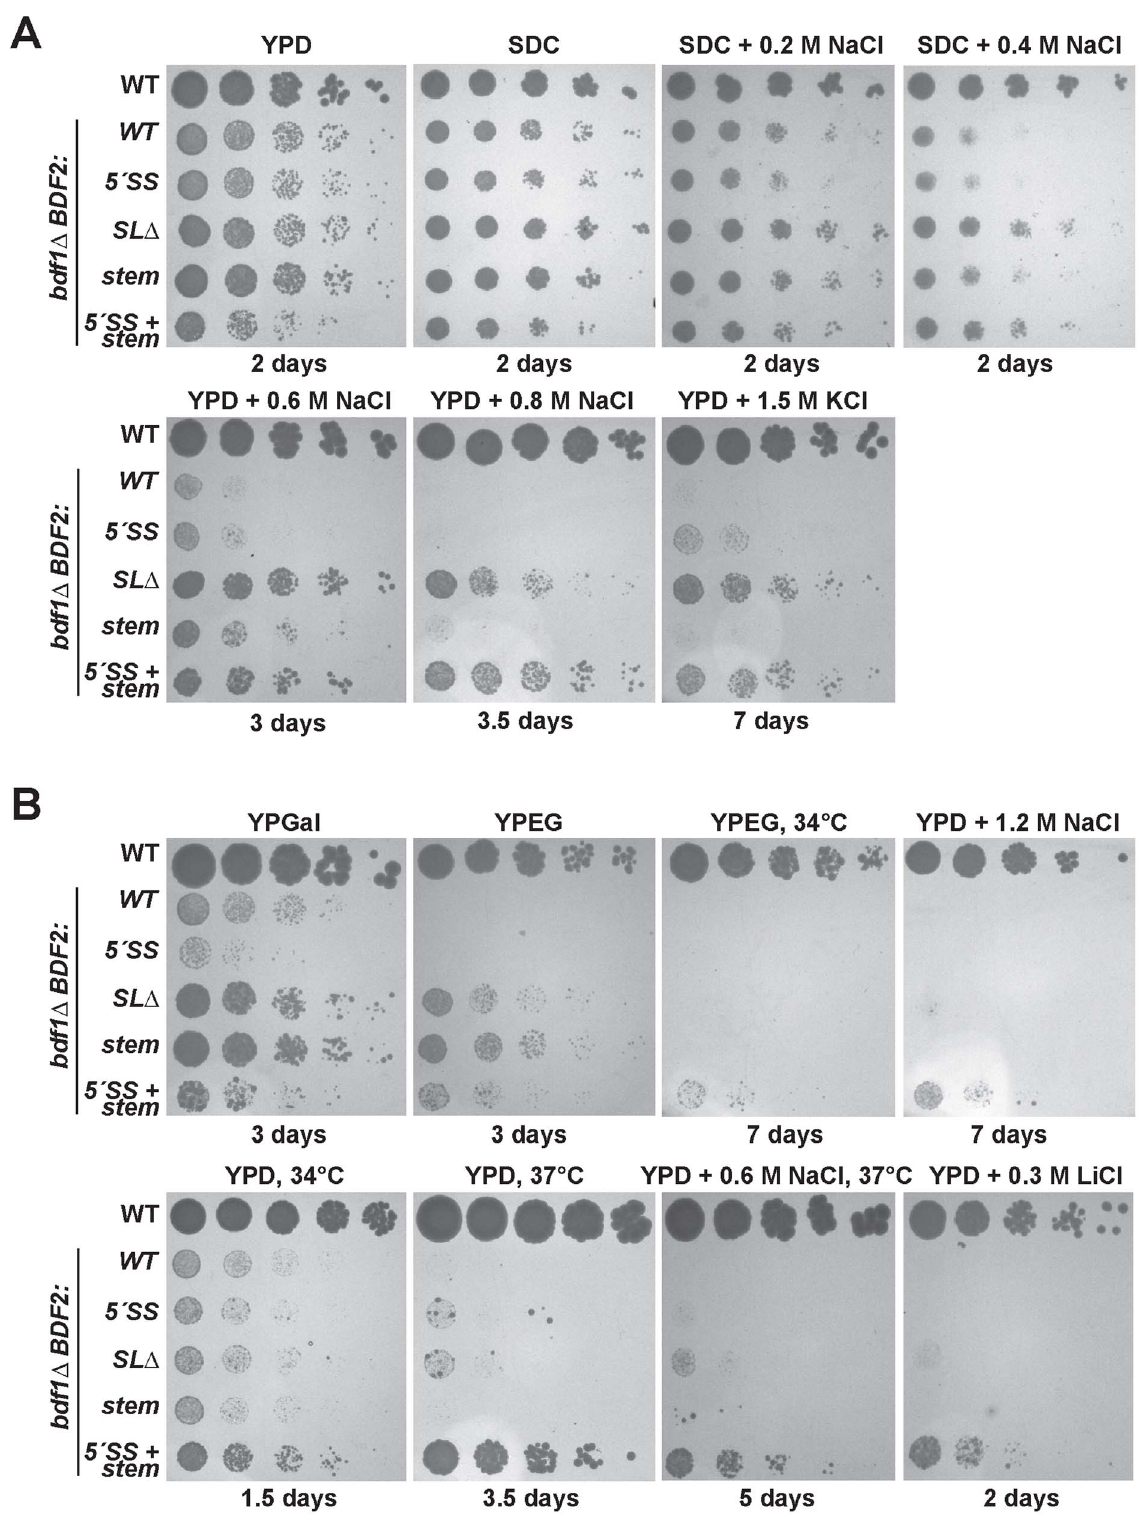
Figure 2. Mutation of the Rnt1p target stem-loop and 5 9 -splice site suppresses bdf1 D growth defects in various environmental conditions. The top row of spot dilutions in each panel is the wild-type (WT) parent strain. The rest are from the bdf1 D background with either WT BDF2 , mutations in the 5 9 -splice site ( 5 9 -SS ), deletion of the Rnt1p stem-loop ( SL D ), mutation of the Rnt1p stem-loop ( stem ), or both ( 5 9 -SS + stem ). Unless indicated otherwise, growth was conducted at 30 u C for the indicated number of days. A . Inactivating Rnt1p cleavage rescues bdf1 D salt sensitivity. The differences between the BDF2 stem mutation ( stem ) and the deletion of the stem ( SL D ) are due to an additional 3 9 -SS introduced by the stem mutation. B . Inactivating Rnt1p cleavage rescues the inability of bdf1 D to grow on non-fermentable carbon (YPEG) and improves growth on galactose (YPGal). Simultaneous inactivation of both Rnt1p- and spliceosome-mediated decay rescues growth at elevated temperatures and in lithium stress. doi:10.1371/journal.pgen.1004661.g002 PLOS Genetics | www.plosgenetics.org